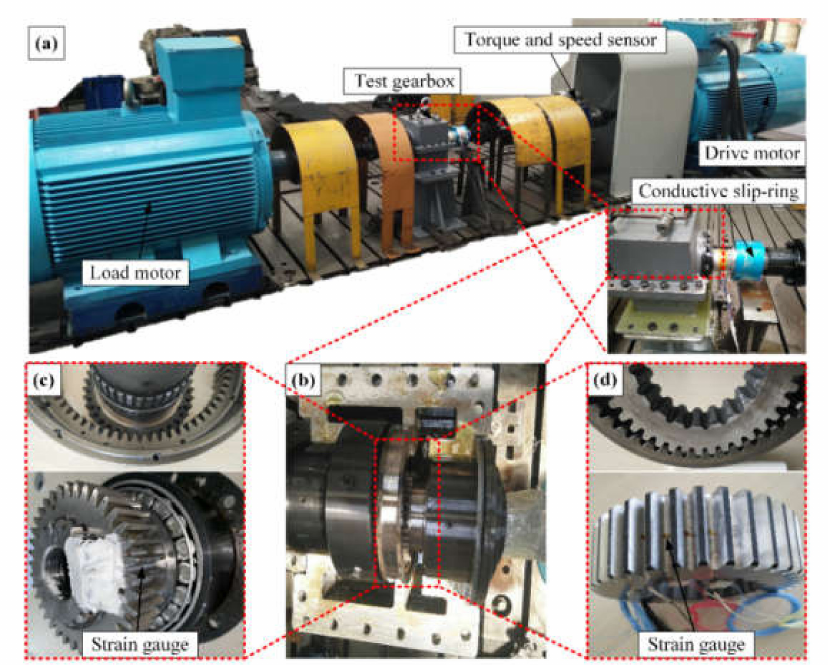
Figure 16. Main test setup: ( a ) transmission system; ( b ) gearbox assembly; ( c ) HCR internal spur gear drive attached by strain gauges; ( d ) involute internal spur gear drive attached by strain gauges. Strain gauges are attached to the adjacent bottom of tooth space for the involute pinion and HCR pinion. Every strain gauge is located on the middle of the tooth root along the tooth width, and the position in the tooth depth direction is shown in Figure 17. The filet stress is given by σ = E ε , where E represents the elastic modulus of the gear material and ε is the filet strain measured by the strain gauge.